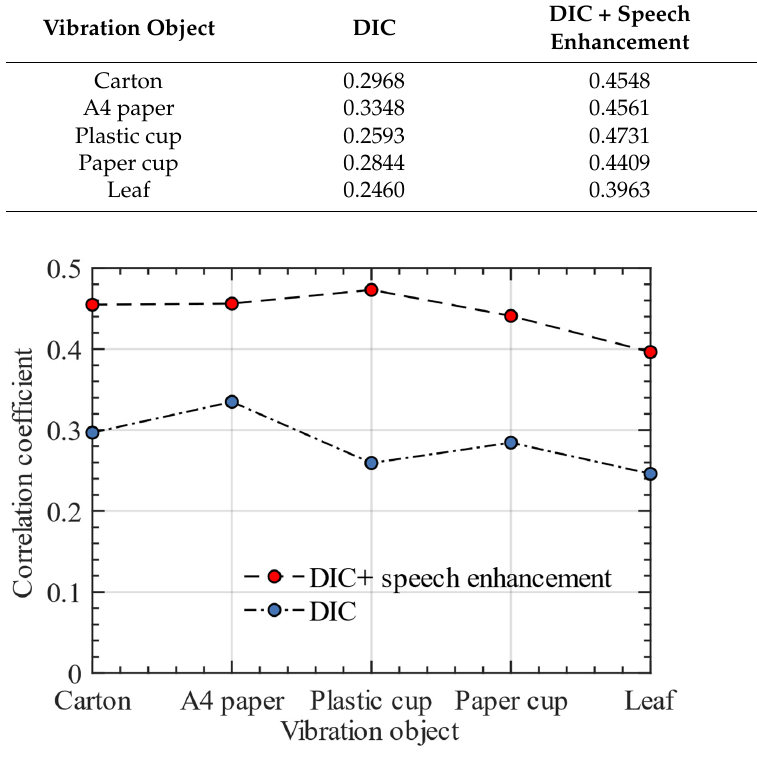
Figure 13. Accuracy comparison of sinusoidal signal reconstruction with and without enhancement.